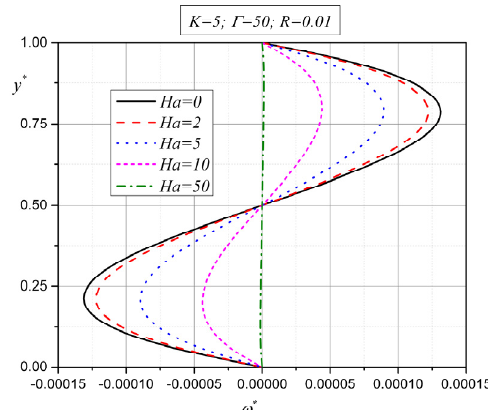
Figure 9. Influence of Hartmann number on microrotation ω * .